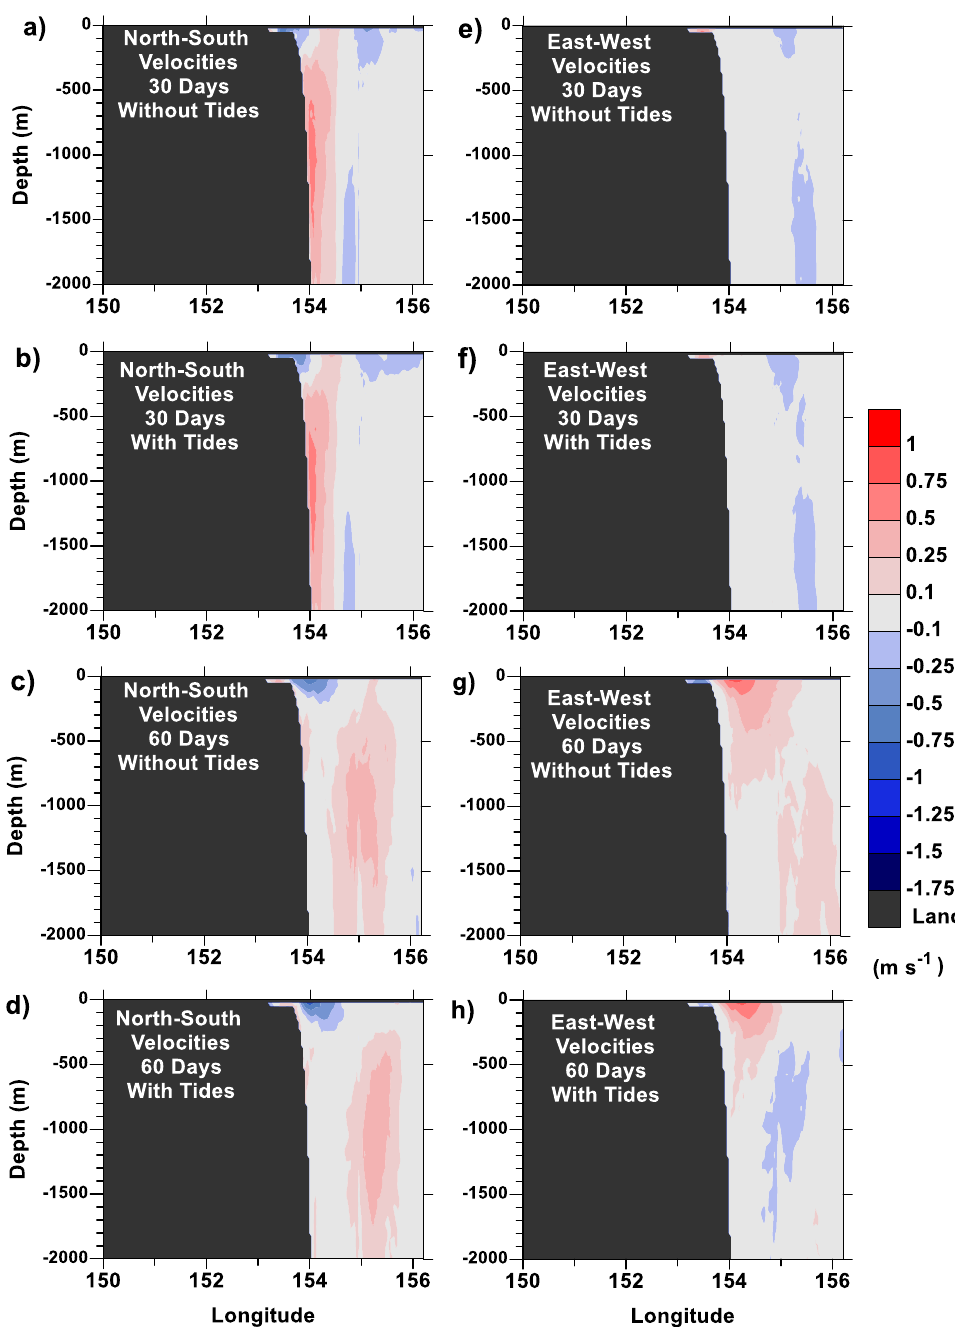
Fig. 10 Vertical transects in longitude at 26 o S of the North–South velocities for the a non-tidal and b tidal simulations at 30 days and c and d at 60 days, respectively, and of the East–West for the e non-tidal and f tidal simulations at 30 days and g and h at 60 days,